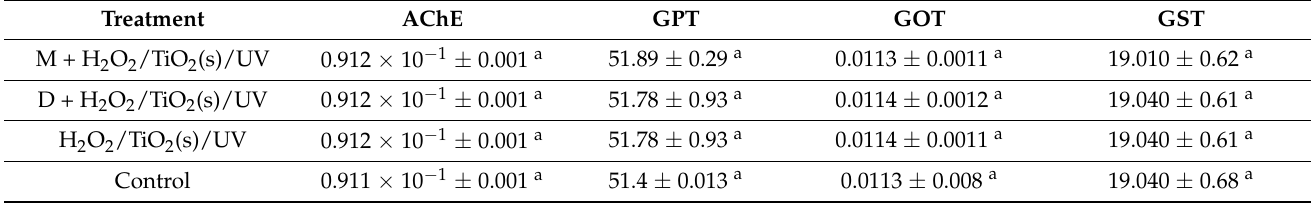
Table 2. Effect of TiO 2 (s)/H 2 O 2 /UV with and without insecticides on the activity of some biochemical parameters in rats.